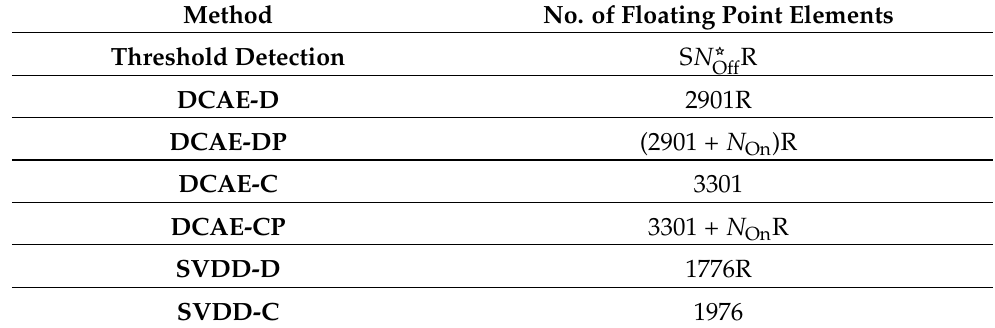
Table 7. Space complexity of